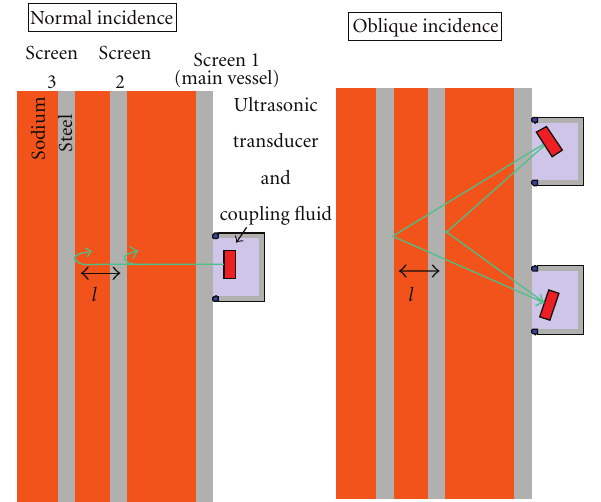
Figure 4: Inspection through screens, for a normal incidence with a transducer working in pulse/echo mode (left) and nonnormal inci- dence with a pitch-catch configuration (right).